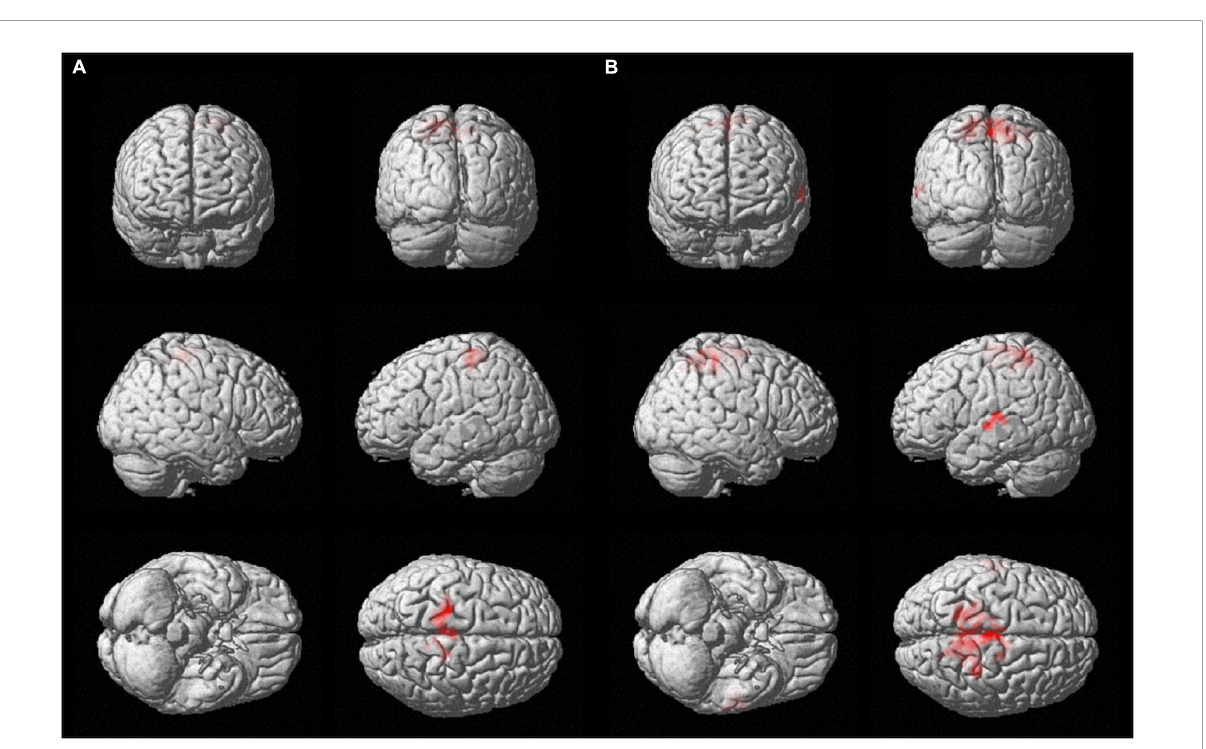
navigation, leading to higher experimental control and reduced MEP variability (Julkunen et al.,